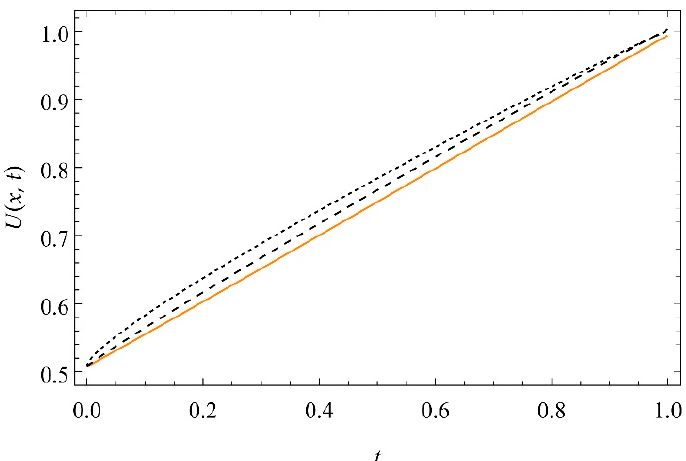
Figure 17. The sketch of ℏ -curve for the 𝑈 against ℏ for considered Equation (45) at ( a ) 𝑛 = 1 and ( b ) 𝑛 = 2 when 𝑡 = 0.01, 𝑥 = 0.5 for sundry values of 𝛼 .